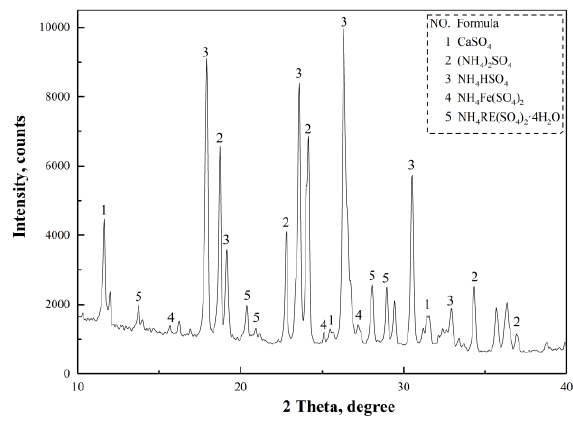
Figure 22. XRD pattern of the crystal precipitation.